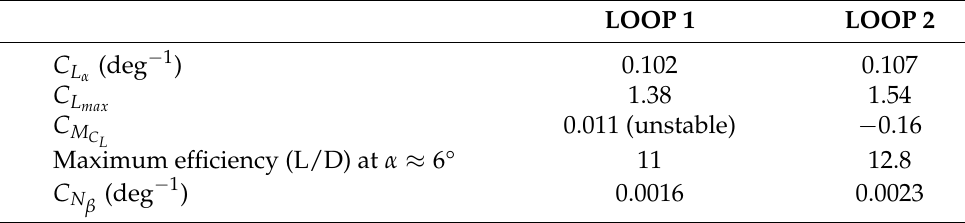
Figure 11. Comparison of the drag polar curves for the two design loop. V = 35m/s, Re = 315,000. Table 6. Aerodynamics summary